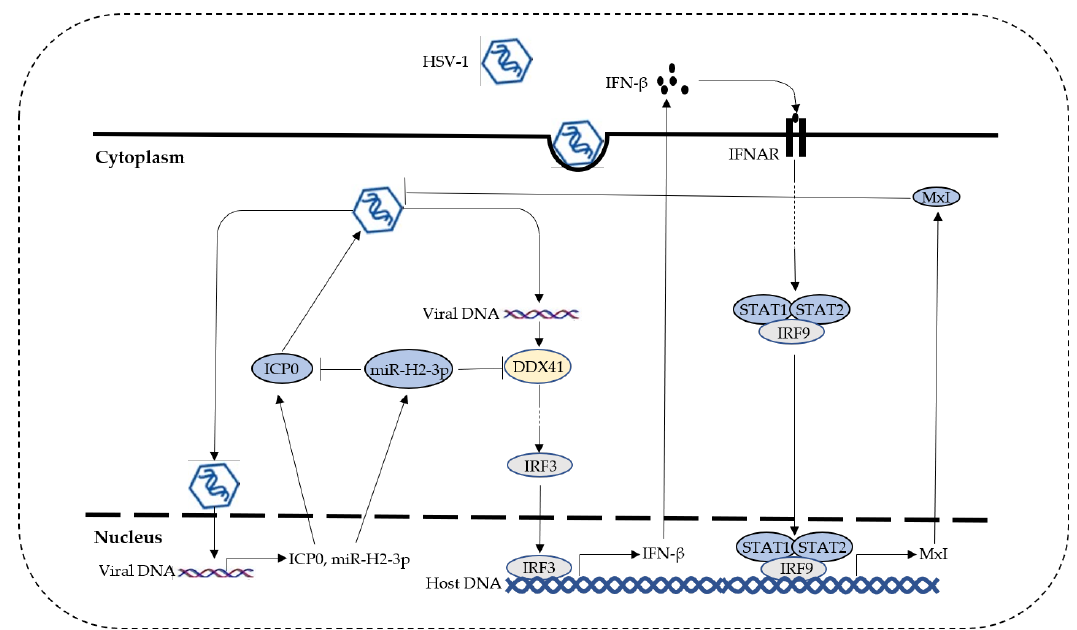
Figure 7. Schematic regulatory relationship involving HSV-1, ICP0, miR-H2-3p, DDX41, and MxI. HSV-1-infected host cells produce viral protein ICP0 and miR-H2-3p. ICP0 can promote viral replication in the early stage, while miR-H2-3p can repress the expression of ICP0 and DDX41. Meanwhile, viral DNA released into the cytoplasm is recognized by DDX41, triggering the production of IFN- β . IFN- β -induced antiviral effector protein MxI inhibits HSV-1 replication. The miR-H2-3p